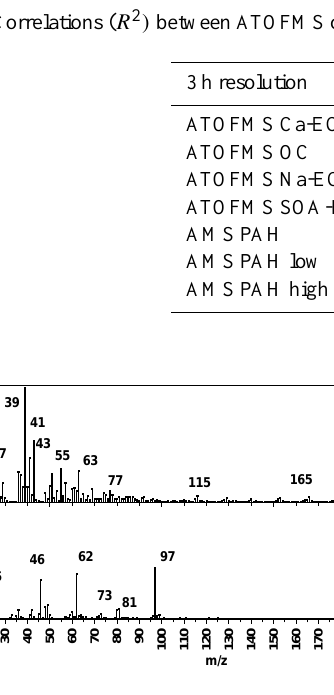
Fig. 6. Average mass spectra for all hit particles during the REPAR- TEE I campaign containing values of peak height at m/z 55 higher than